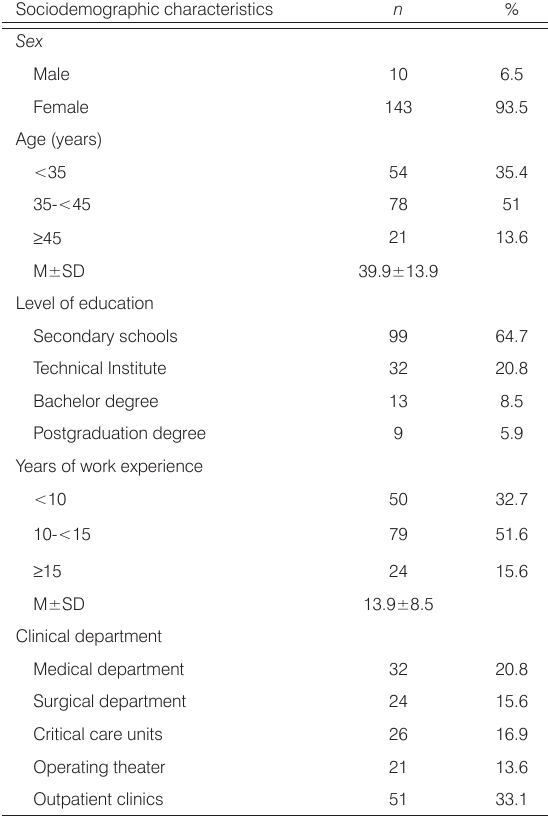
Table 1. Frequency distribution of studied nurses regarding sociodemographic characteristics (N =